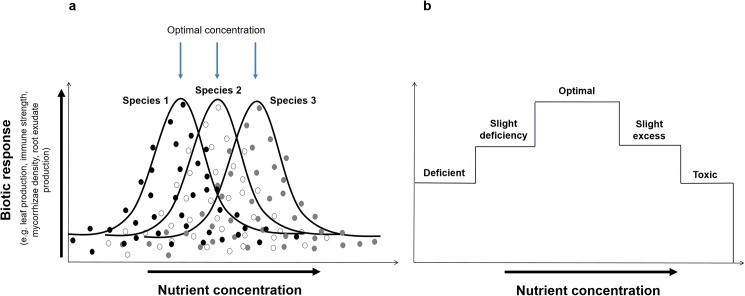
Theoretical relationships between biotic response and nutrient concentration for various plant species occurring in the same environment.The response of plants in terms of vigour to a particular nutrient are invariably bell-shaped curves (a) as opposed to distinct steps (b) delineating zones where concentrations of a particular nutrient are deficient, optimal or toxic.